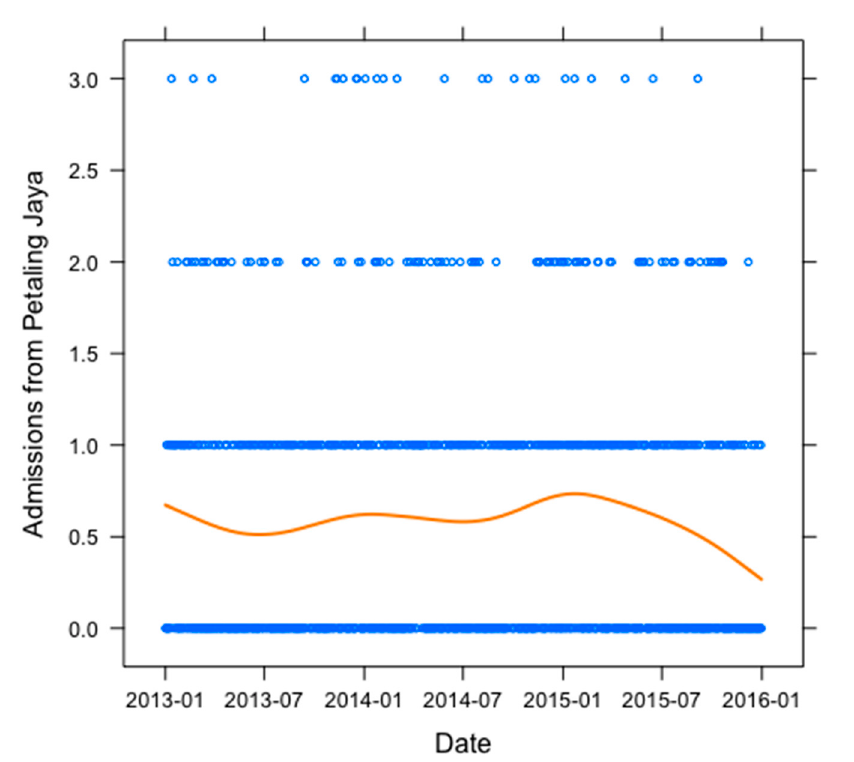
Figure 1. Seasonal pattern of daily admissions for chronic respiratory diseases for Petaling Jaya Residents 2013–2015.